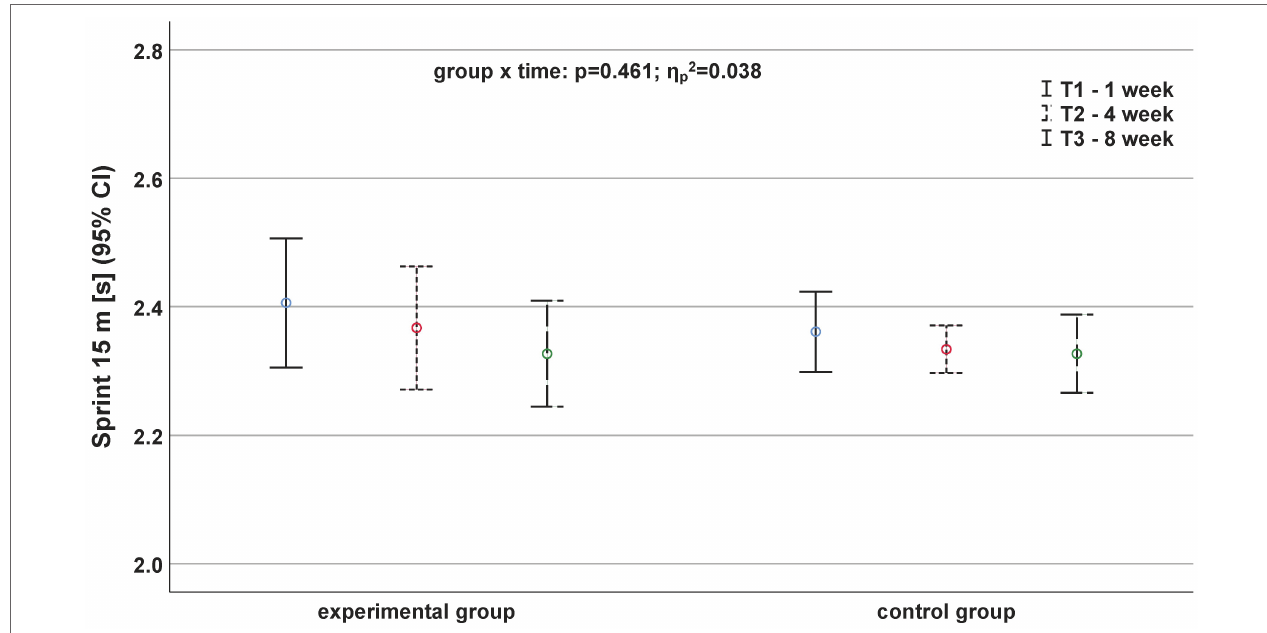
FIGURE 1 | Development of sprinting performance based on the parameter sprint 15 m before (continuous black line), after 4 weeks (fine dashed black line), and after (roughly dashed black line) the exercise program depending on the